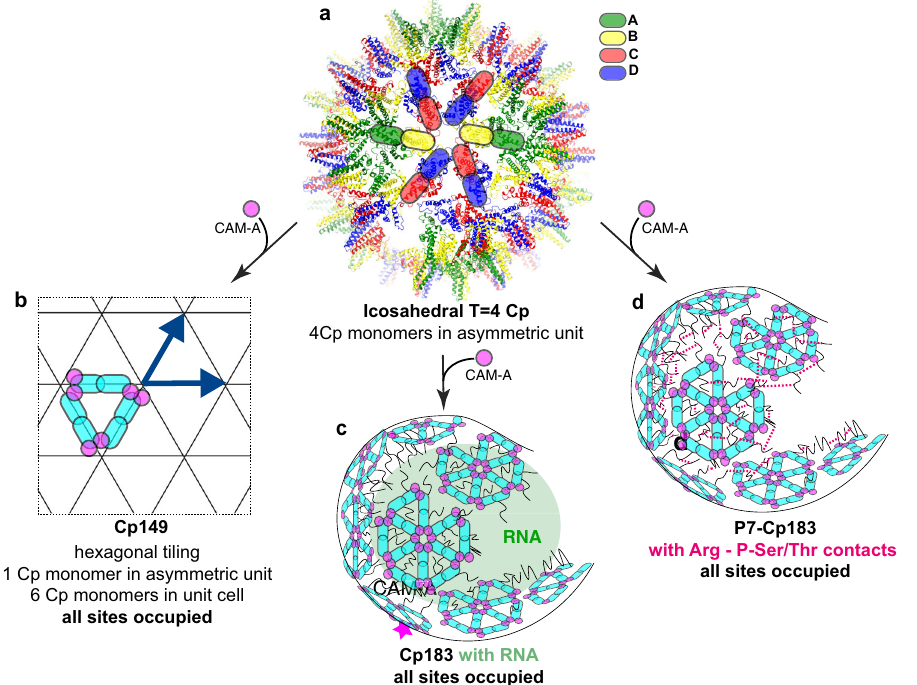
Fig. 5 | A molecular model for capsid assembly modulation. a Capsid without CAM. b , c Models of capsid and dimer rearrangements in the presence of CAM-A. b The hexagonal tiling resulting from capsid opening and loss of the pentameric sitesisshownwithallmoleculescoloredincyan;CAM-Aareshowninpink. c Effect of CAM-A on Cp183 capsids. All CAM binding sites are occupied, and pentameric